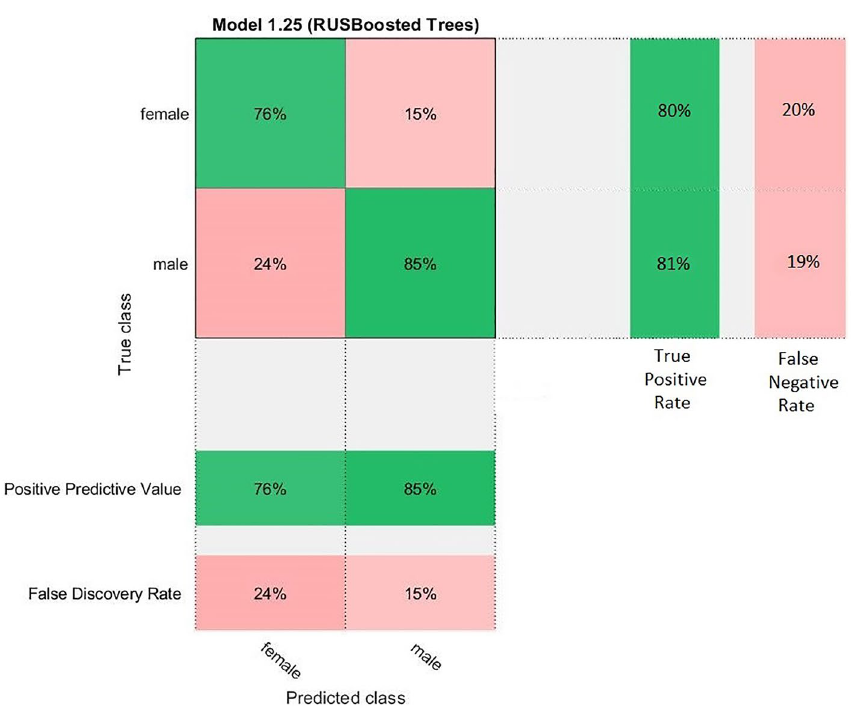
Figure 4. The Confusion Matrix for all classes. Rows represent the real sex of chicks which were determined after hatching, columns represent the classified sexes. Each quarter represents the corresponding accuracy. By quarters, up-left: 76% of the females were classified correct, bottom-left: 24% of the females were classified wrong, up-right: 15% of the males classified wrong, bottom-right: 85% of the males were classified